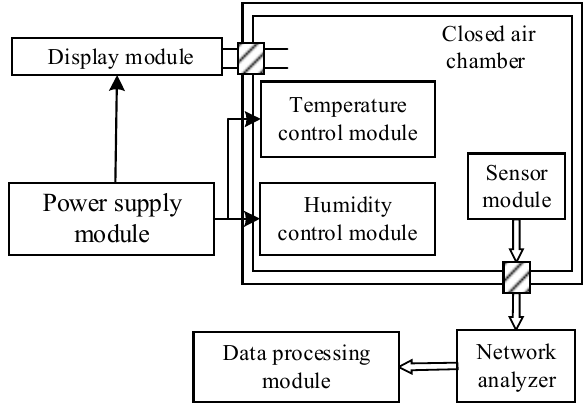
Figure 3. Structure diagram of humidity measurement system.